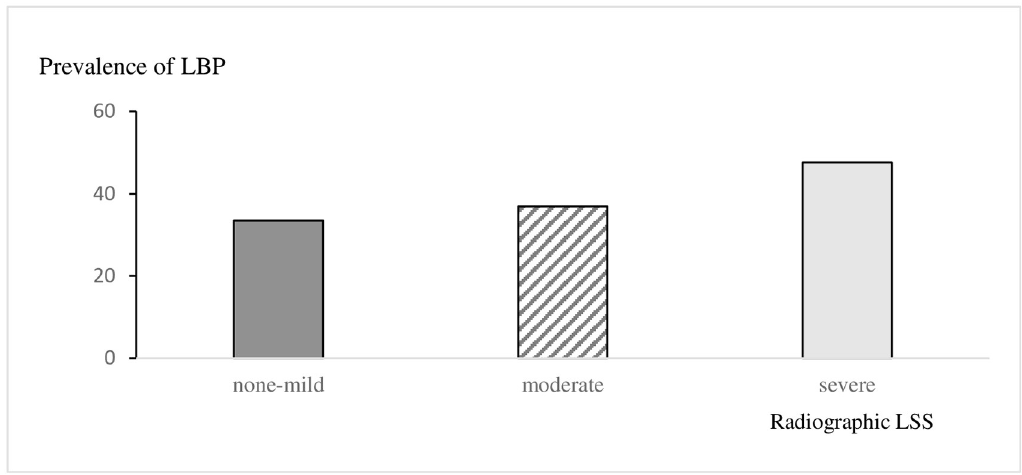
Fig 6. LBP vs. radiographic LSS. LBP prevalence increases 0.5-fold as the severity of the disease progresses from non-mild to severe, while it increases 0.6-fold with a moderate-to-severe progression.